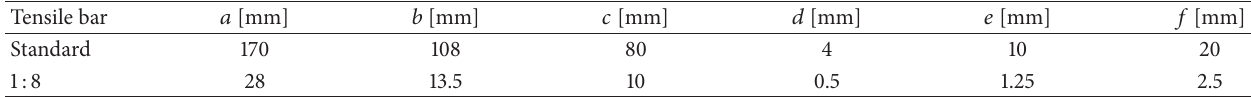
Table 2: Dimensions of tensile bars.